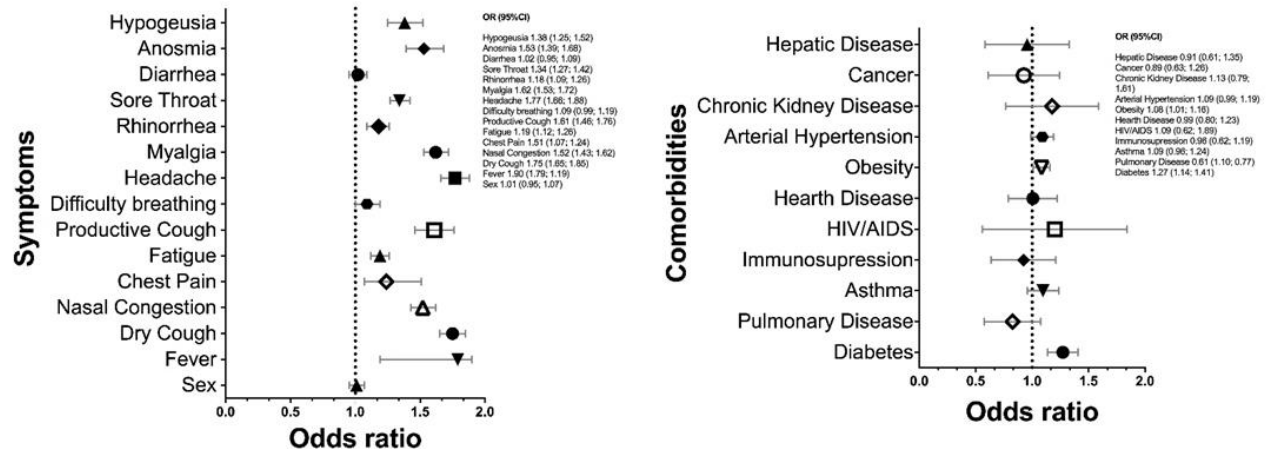
Figure 4. Symptoms and comorbidities are highly associated with SARS-CoV-2 infection. ( A ) Fever, headache, and dry cough were the most characteristics symptoms among patients with SARS-CoV-2 infection; sex did not exhibit an association with the presence of the virus. Meanwhile, ( B ) the underlying diseases that demonstrated a positive relation with SARS-CoV-2 were diabetes, obesity, and hypertension. Table 3. Risk factors associated with the COVID-19 clinical